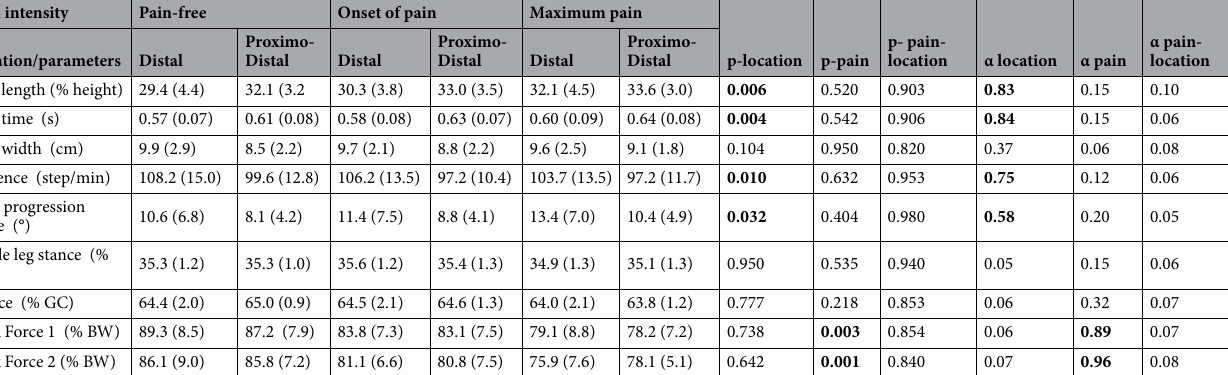
Table 2. Gait parameters during the different phases of the gait in the ischemic leg, relative to locations of ischemia (mean (SD)) . p-location: p value with three-way ANOVA for location of ischemia differences during all phases. p-pain: p value with three-way ANOVA for differences between pain-free and maximum pain for both locations of ischemia. p-interaction pain-location: p value for interaction effects between pain and location of ischemia. GC gait cycle and BW body weight.